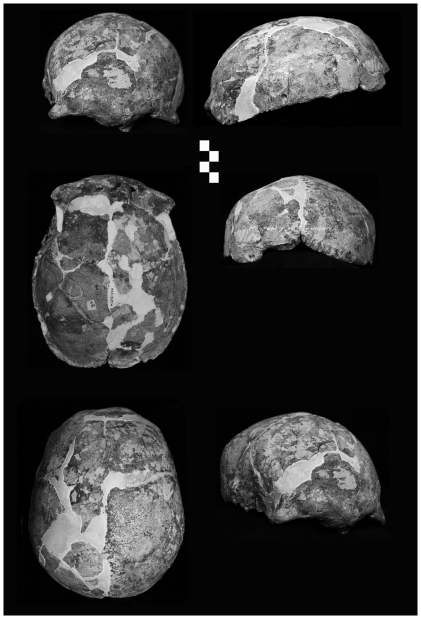
Maludong 1704 calotte (each bar = 1 cm).